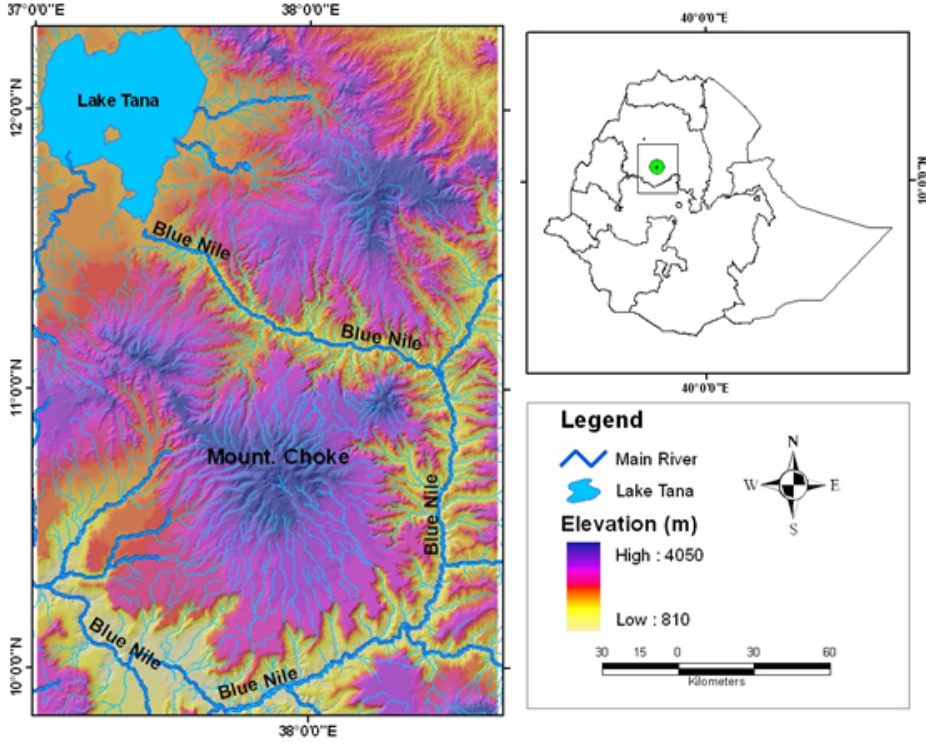
Fig. 1. The location and topography of the study